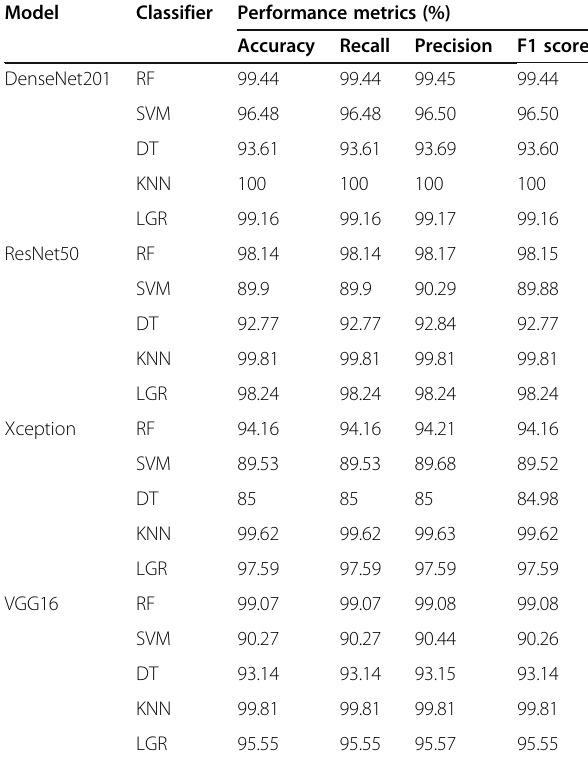
Table 2 The results were obtained by applying pre-trained models in combination with five ML classifiers